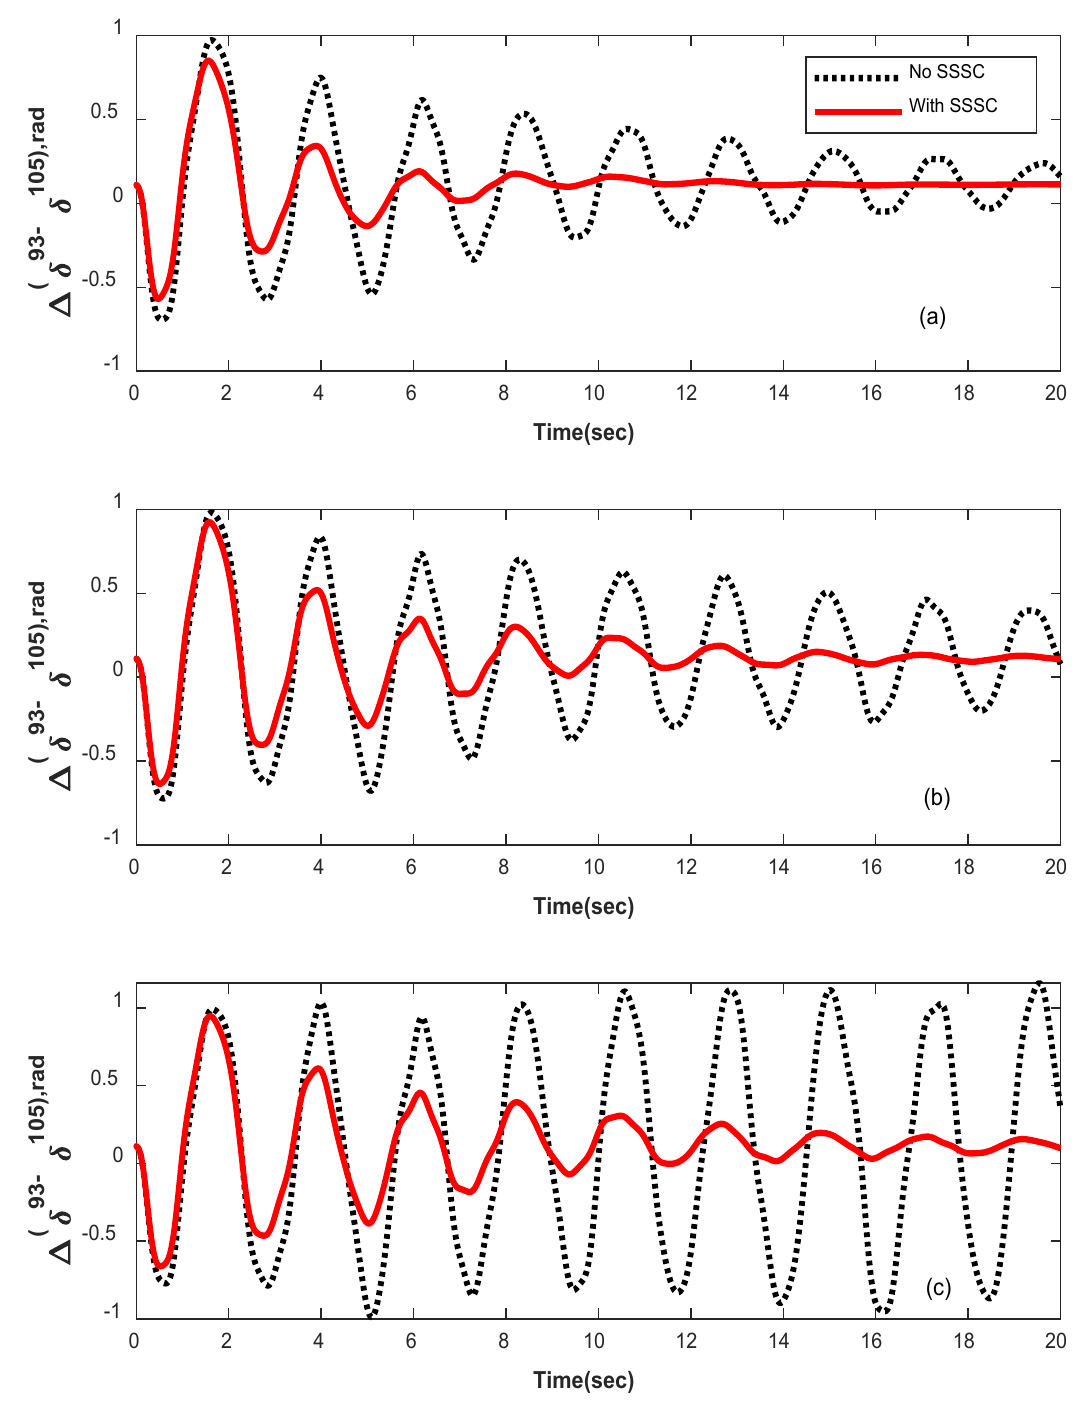
Figure 19. Nonlinear simulations using robust ϕ -based stabilizer for different operating conditions (angle difference between G 93 and G 105 ) (( a ) light loading, ( b ) Normal loading, and ( c ) Heavy loading). Table 12. Parameters of robust SSSC-based stabilizer of IEEE 50-Machine Power System.